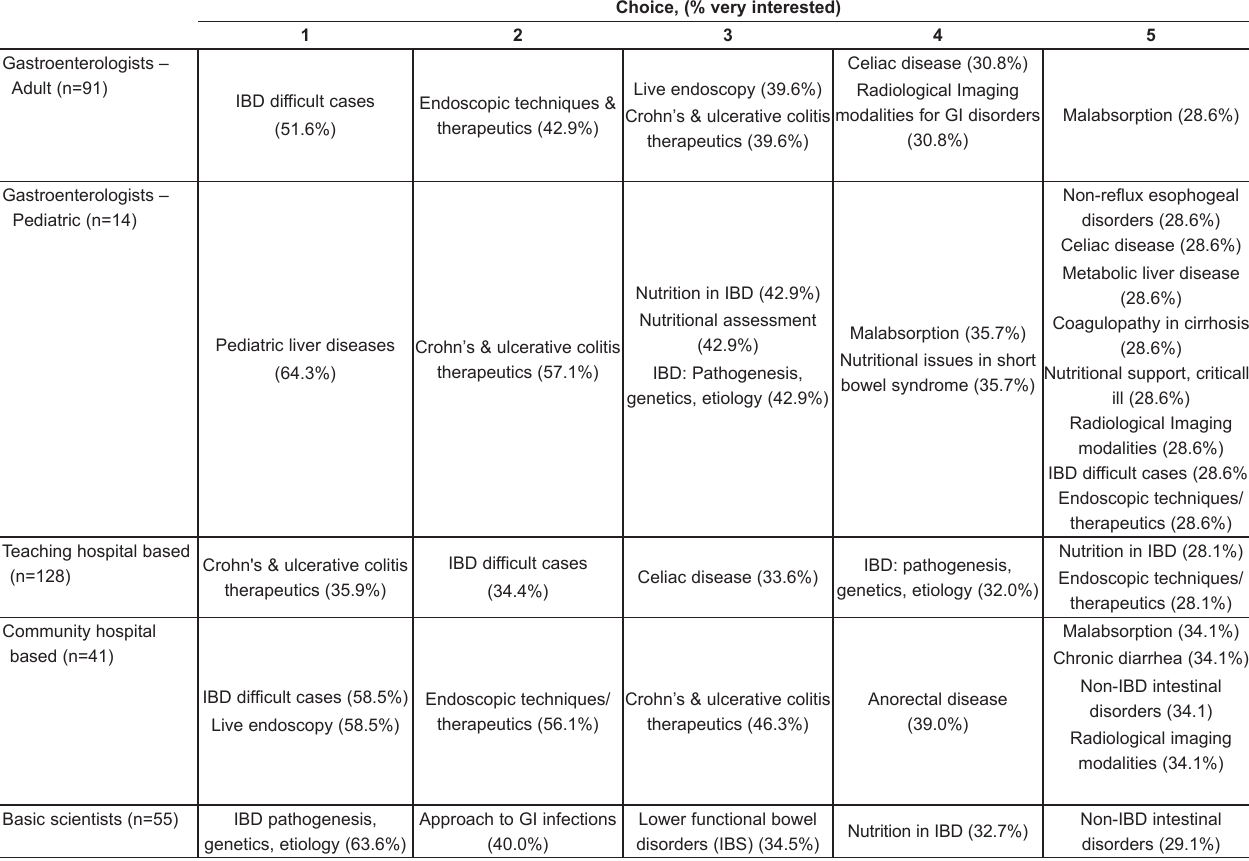
TAble 1 Most popular educational topics according to respondent